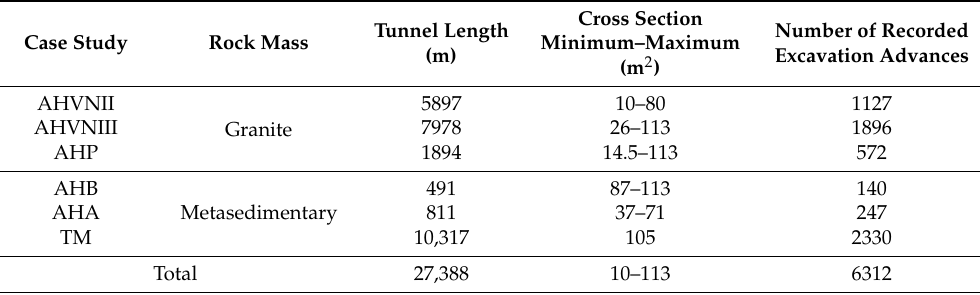
Table 1. Summary of the characteristics of the considered case studies.